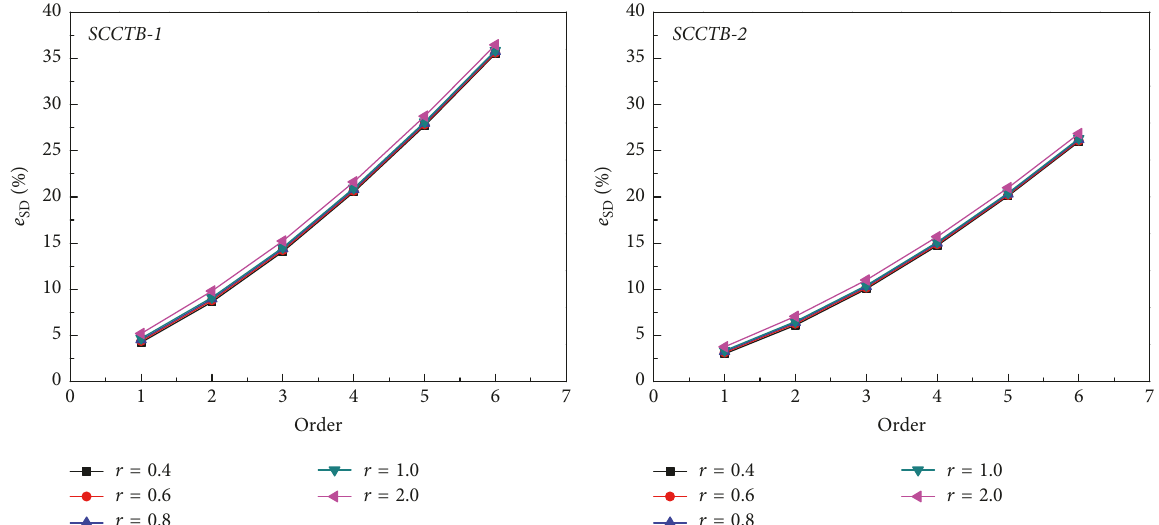
Figure 4: Relationship between the shear deformation effect and the mode orders of natural vibration